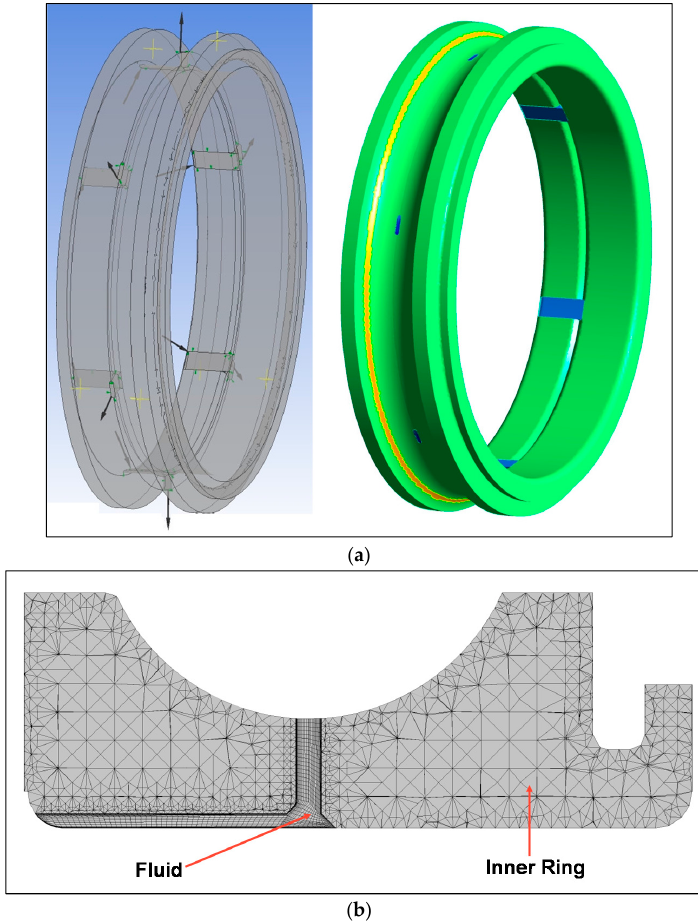
Figure 14. ( a ) The Inner ring of the bearing. The arrows are for the oil motion (LHS) and the bright line on the isotachs (RHS) is for the heat flux into the material by the rolling elements; ( b ) A perpendicular cut through the mesh (Inner ring and Fluid).